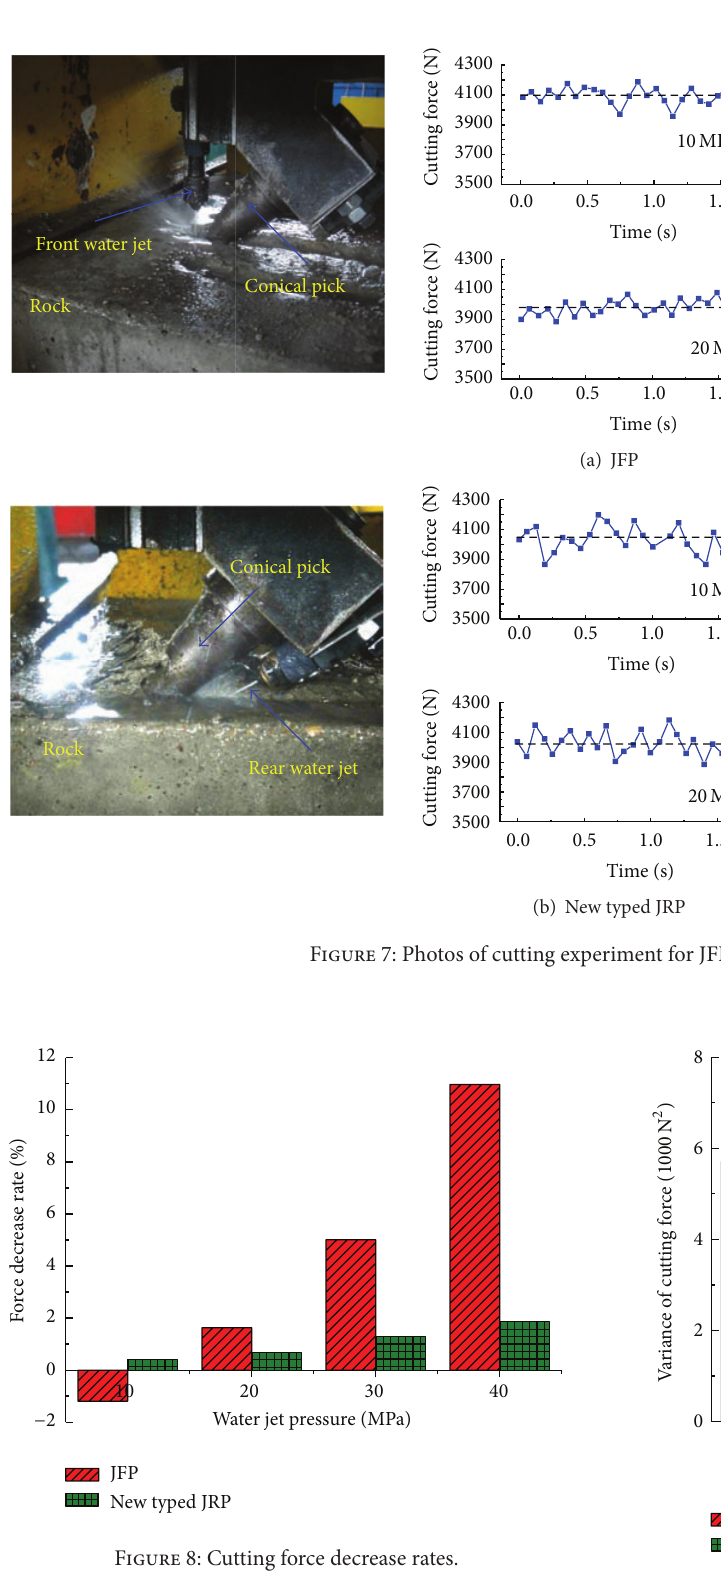
Figure 9: Variance of the cutting